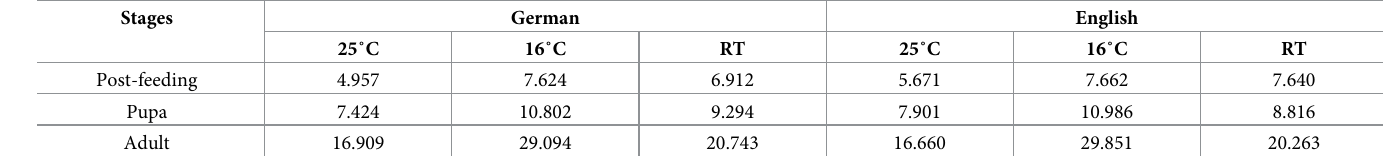
Table 2. Mean time (days; n = 3 replicates) for C . vicina to reach the post-feeding, puparial, and adult stages. Stages